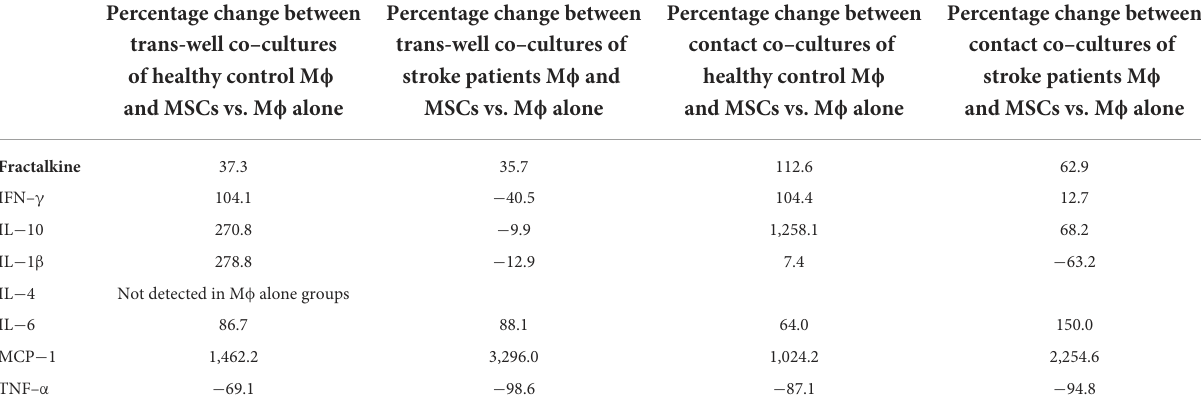
TABLE 1 Percentage change between secretome released from MSC-M φ co-cultures and M φ alone. Percentage change between Percentage change between Percentage change between Percentage change between trans-well co–cultures trans-well co–cultures of contact co–cultures of contact co–cultures of of healthy control M φ stroke patients M φ and healthy control M φ stroke patients M φ and MSCs vs. M φ alone MSCs vs. M φ alone and MSCs vs. M φ alone and MSCs vs. M φ alone Fractalkine 37.3 35.7 112.6